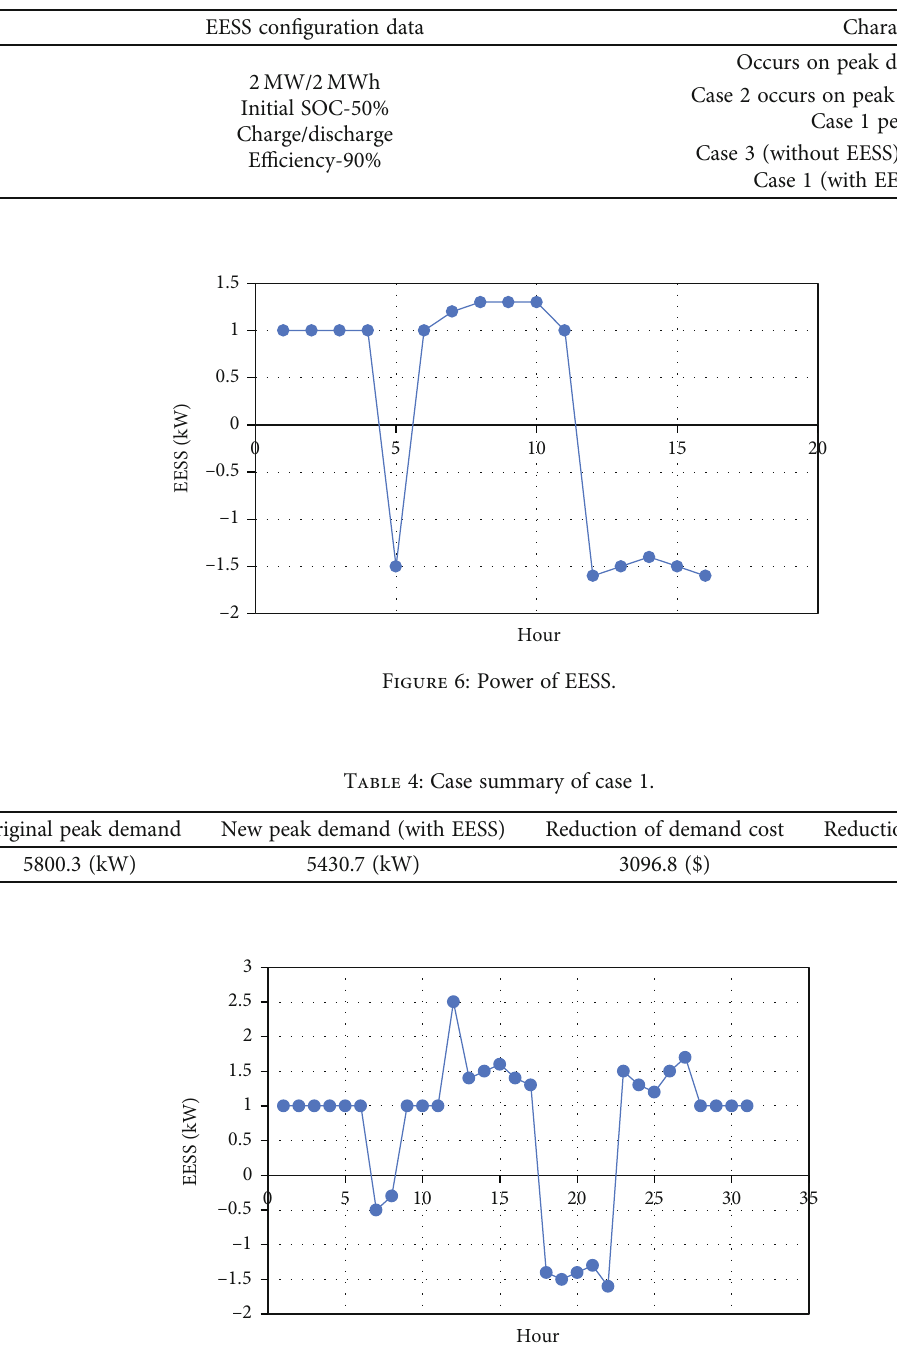
Table 3: Simulation of state EESS.